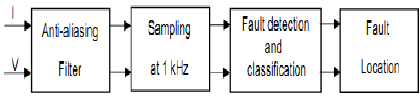
Fig. 3: The steps performed by the digital relay for fault detection, classi(cid:28)cation and localization. The currents and voltage signals are (cid:28)ltered using the antialiasing (cid:28)lter (Butterworth low- pass) and sampled at 1